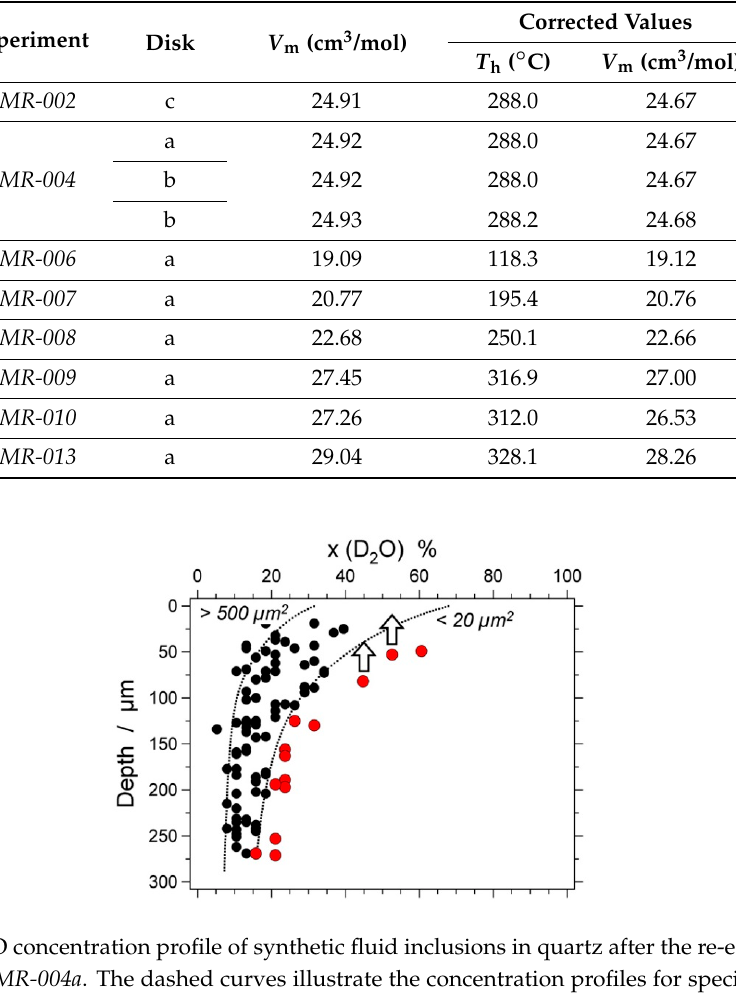
Table 5. Average D 2 O molar volume ( V m ) in the experimental conditions and corrected values of homogenization temperatures and molar volumes in homogenization conditions according to the quartz expansivity and compressibility [20] along the isochores in re-equilibration experiments.